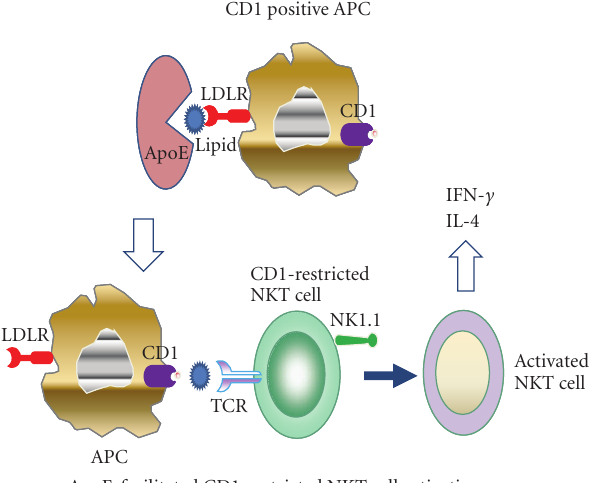
Figure 2: ApoE facilitates the activation of CD1-restricted natural killer T (NKT) cells. Inactivated NKT cells express surface marker of NK1.1 and a semiinvariant T cell receptor (TCR). ApoE facilitates lipid antigen-presentation by CD1 positive antigen presenting cells (APCs) mainly through binding to low-density lipoprotein receptor (LDLR). CD1 molecules present lipid antigens to NKT cells. Upon ligation to CD1 via TCR, naive NKT cells are activated, and respond rapidly to secrete high levels of IFN- γ and IL-4, which play a critical role in the modulation of immune and inflammatory responses.